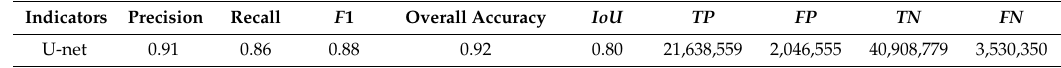
Table 1. Validation of the U-net algorithm identification